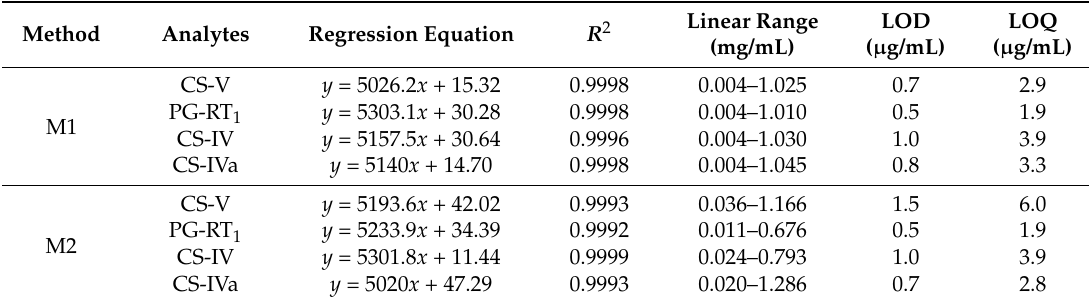
Table 1. Calibration curves, linear range, LOD, and LOQ of the investigated compounds in Methods 1 and 2.